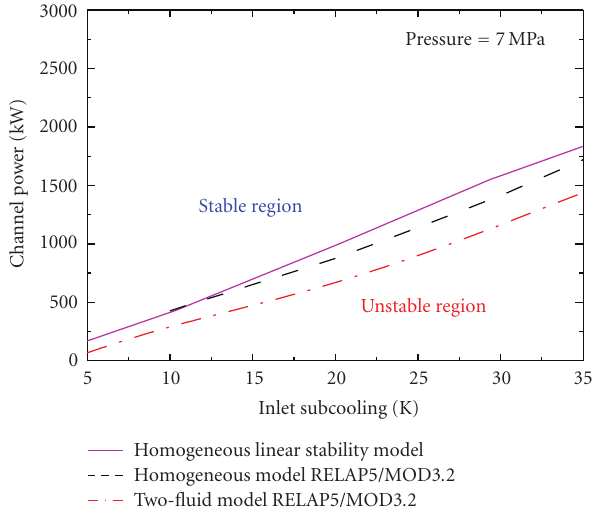
Figure 17: Comparison of stability maps between the homoge- neous model and the two-fluid model